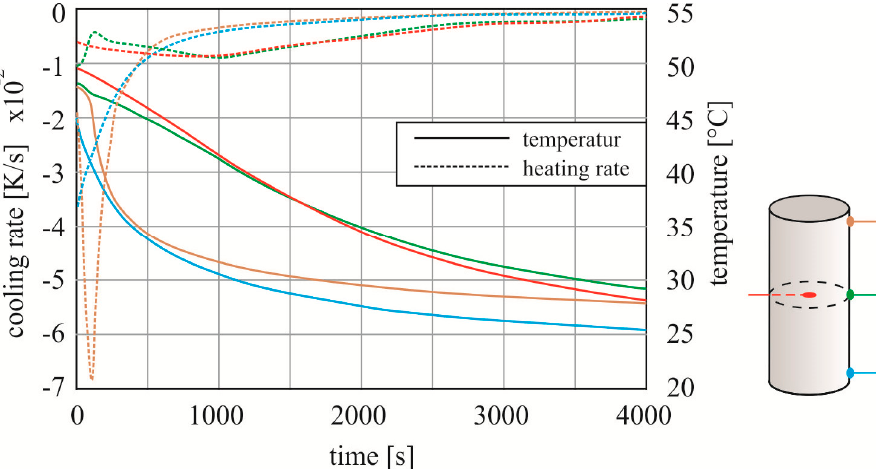
Figure 5. Cooling of the PK 2T specimen in the testing machine direct after removing from the oven.